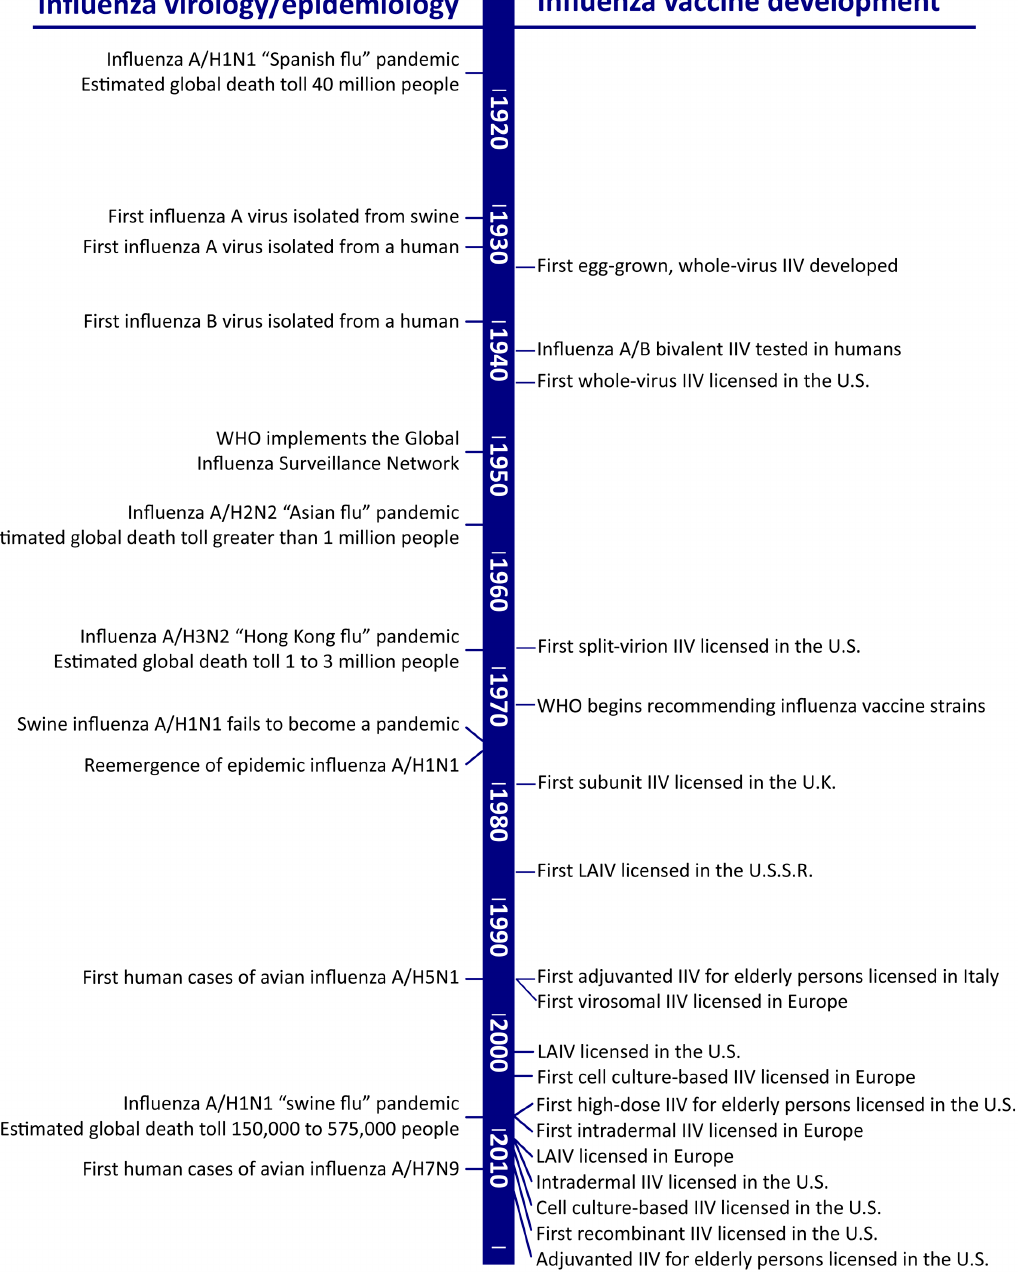
Figure 1. Milestones in the history of influenza vaccines [14–25]. IIV, inactivated influenza vaccine; WHO, World Health Organization; LAIV, live attenuated influenza vaccine.